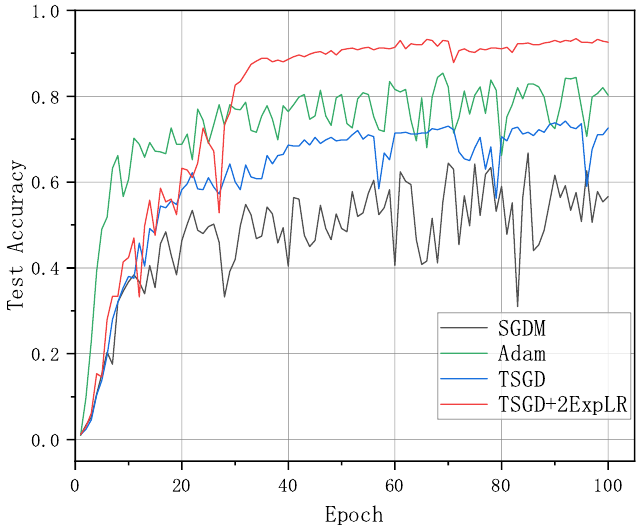
Figure 6. The accuracy of CASIA-FaceV5-ResNet18 on test set.